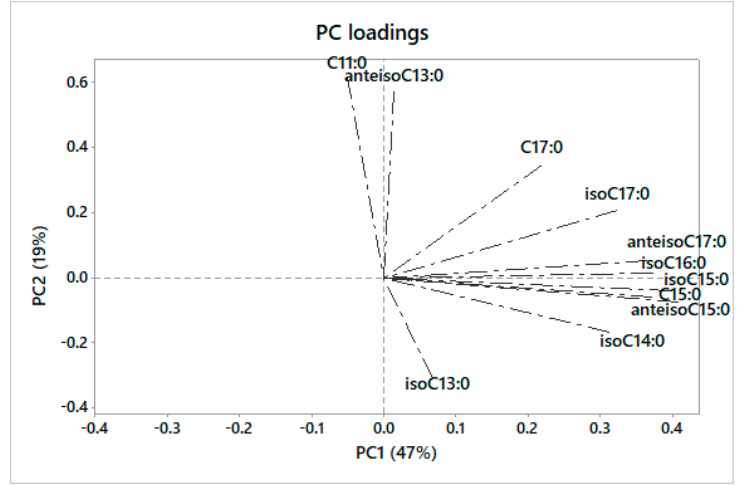
Figure 2. Loadings plot of the two first principal components explaining 47 and 19% of the total variance, respectively.